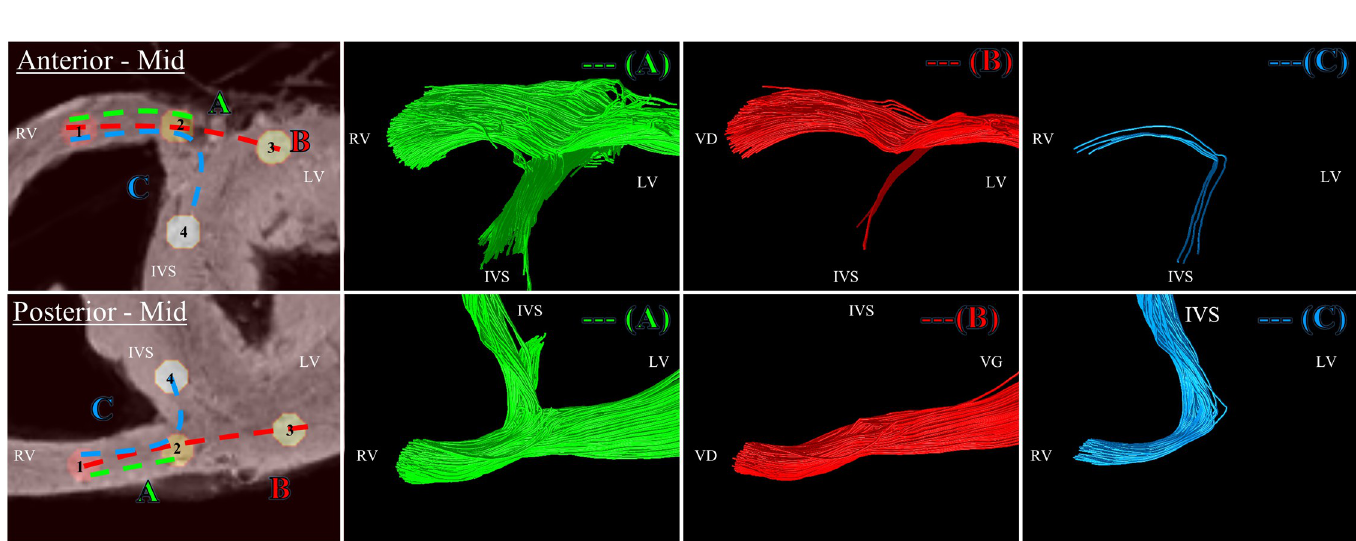
Fig 8. Tractography of the junction obtained with a seeding performed in the mid-ventricular area. Left windows: four cylindrical ROIs: R1 (red), R2 (yellow), R3 (light yellow), R4 (white) were manually defined at the RVIP in the basal area of the anterior (top) and posterior (down) junction. Three arbitrary pathways: A (from ROI R1 to R2) B (from ROI R1 to R2 to R3) C (from ROI R1 to R2 to R4) were also defined as input for computing the streamlines. ROIs and pathways were overlaid on anatomical template images. The other windows correspond to the resulting streamlines in 3D view for each pathway. Anterior (Top) Streamlines split into two output tracts. The fascicle of streamlines going to the IVS leaves the image plane and goes to the wall of the pulmonary artery as described in Fig 6. Pathway (B) and (C) were found connecting. Posterior (Down) Streamlines split into two output tracks located in the IVS, in the free wall (A) but do not cross the posterior singularity. Pathways (B) and (C) were found connecting.